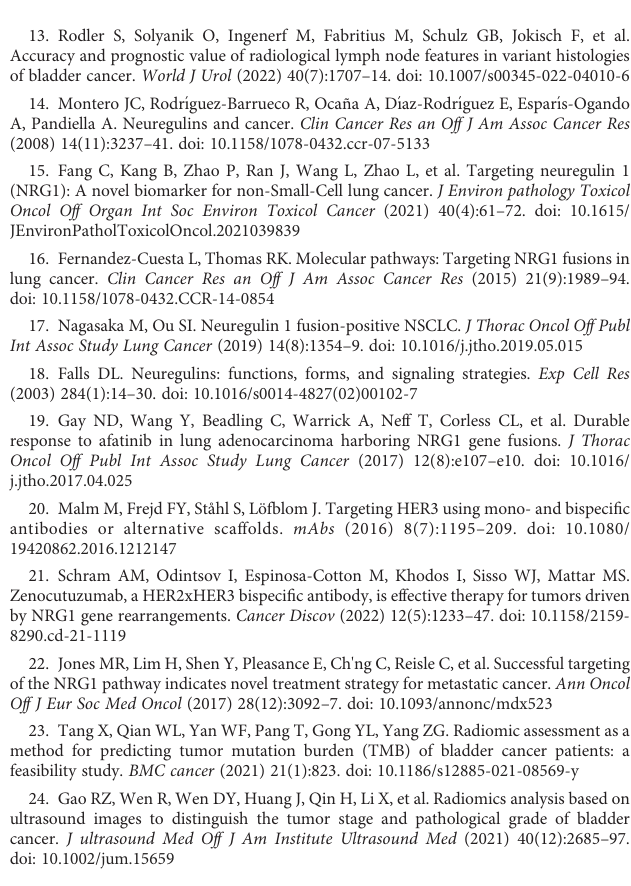
SUPPLEMENTARY TABLE 1 Clinical covariates in high- and low-HRG expression groups. SUPPLEMENTARY TABLE 2 Univariate and multivariate regression analysis of clinical covariates. SUPPLEMENTARY TABLE 3 The E value of HRG and clinical